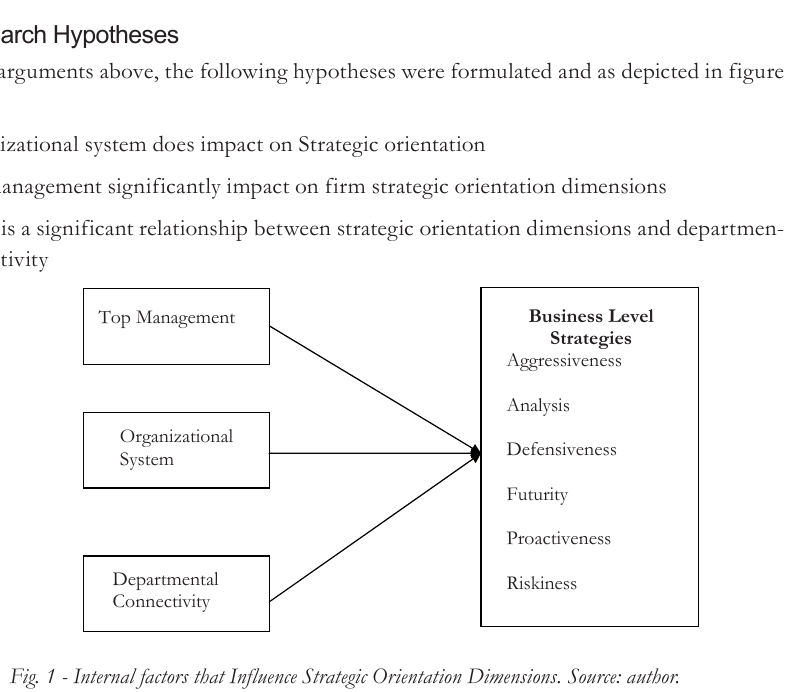
Fig. 1 - Internal factors that Influence Strategic Orientation Dimensions. Source: